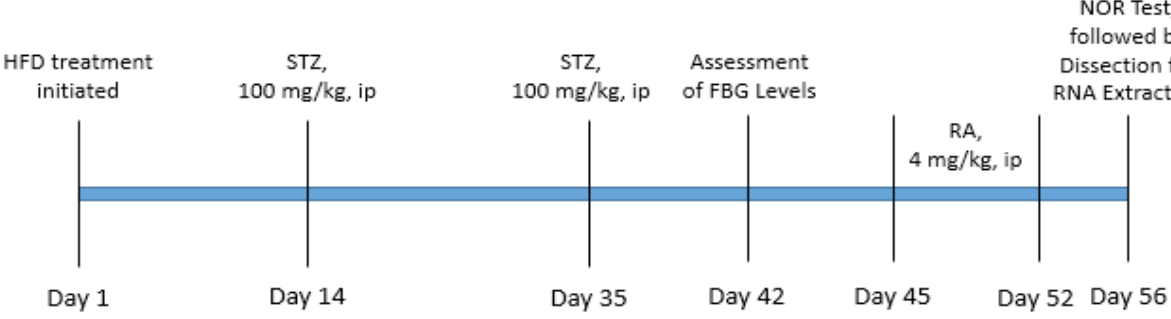
FIGURE 1 - Study Design: Timeline depicting the 56-day period for the induction of diabetes, RA treatment, memory assessment with the NOR test and animal sacrifice for mRNA expression analysis in the brain.